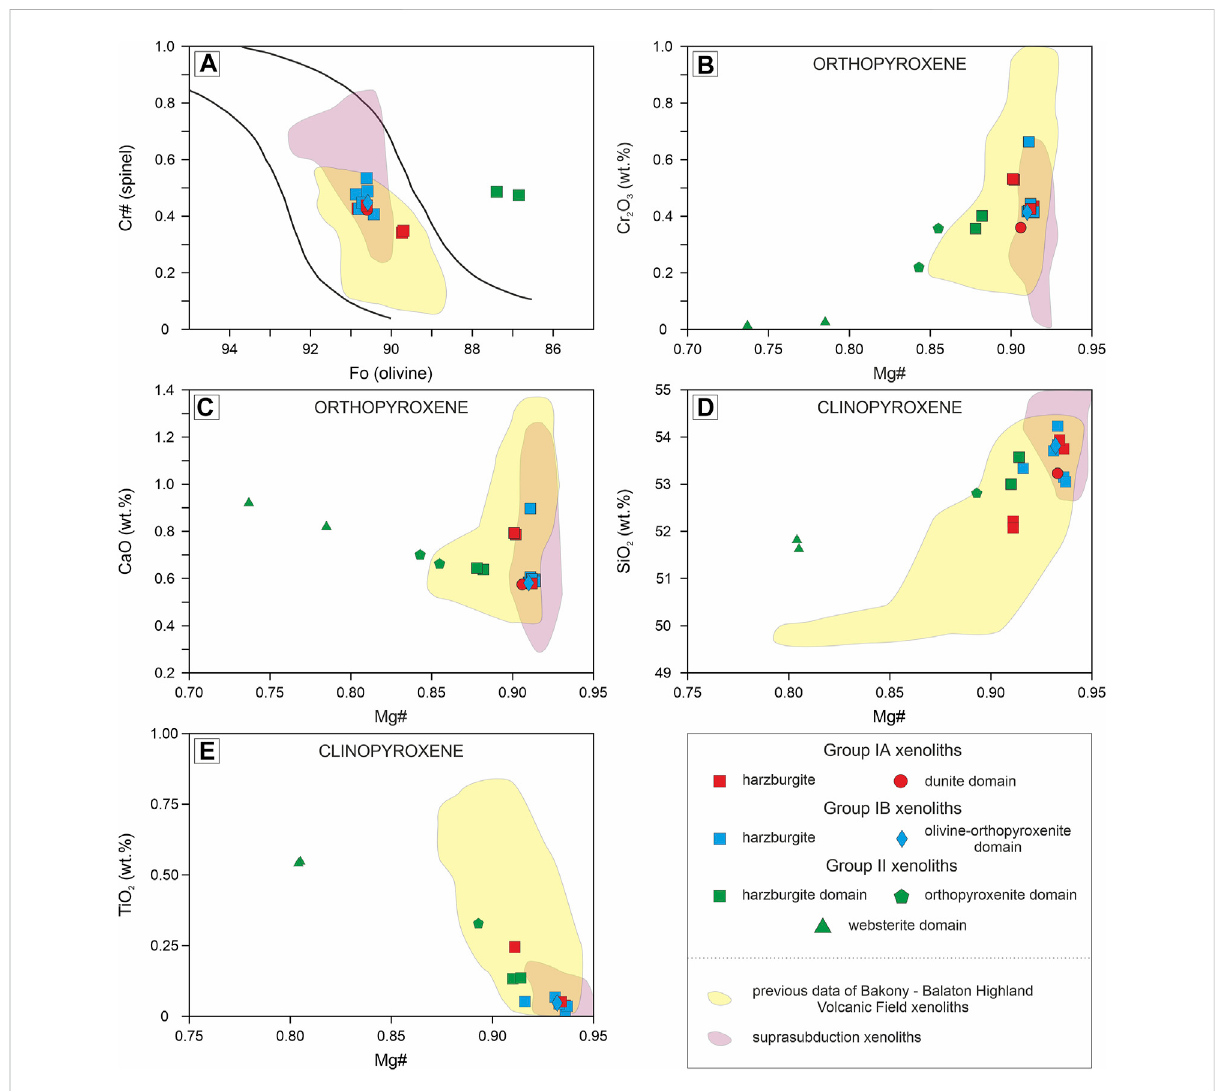
FIGURE 4 Major element composition of the studied MSZK xenoliths. (A) OSMA (olivine-spinel mantle array; Arai, 1994, indicated by solid lines); (B) variation of Mg# vs. Cr 2 O 3 in orthopyroxene; (C) variation of Mg# vs. CaO in orthopyroxene; (D) variation of Mg# vs. SiO 2 in clinopyroxene; (E) variation ofMg# vs. TiO 2 in clinopyroxene. Published BBHVF uppermantle xenoliths: Embey-Isztin etal., 1989;2001;2014;Downes etal., 1992; Bali et al., 2002; 2007; 2018; Dobosi et al., 2003; 2010; Demény et al., 2004; Hidas et al., 2007; 2010; Berkesi et al., 2012; Nta fl os et al., 2017; Créon et al., 2017b. Data of supra-subduction xenoliths: McInnes et al., 2001; Ishimaru et al., 2007; Aradi et al., 2020. Mg#=Mg/[Mg+Fe 2+ ]; Fo refers to the forsterite content of olivine;